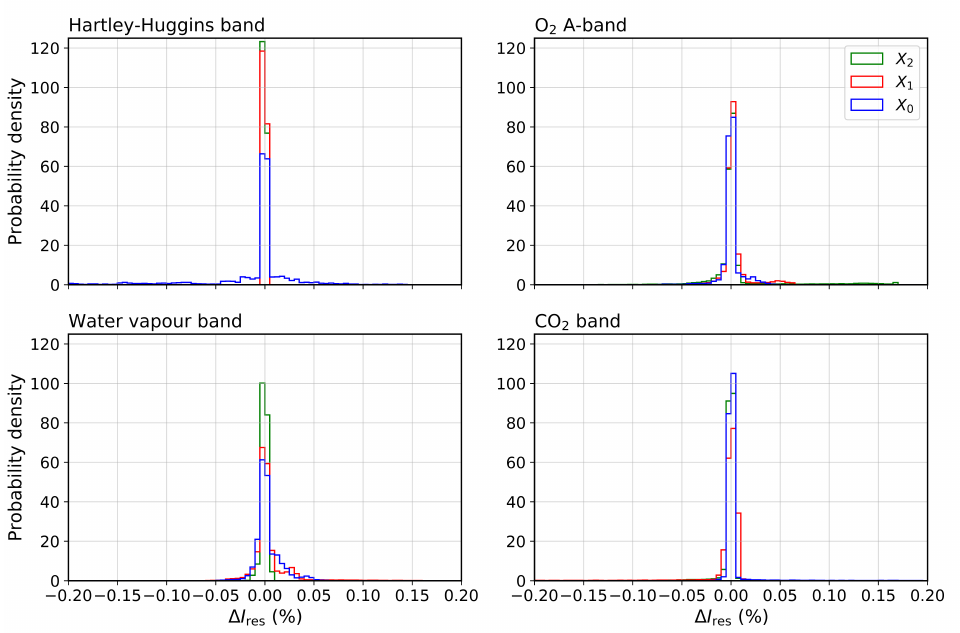
Figure 7. Probability density of the residuals for the single CLSR method and for several matrix configurations: X 0 , X 1 and X 2 . Each plot represents the absorption bands: Hartley–Huggins, O 2 A-, water vapour and CO 2 bands. The case presented corresponds to the tropospheric aerosol.